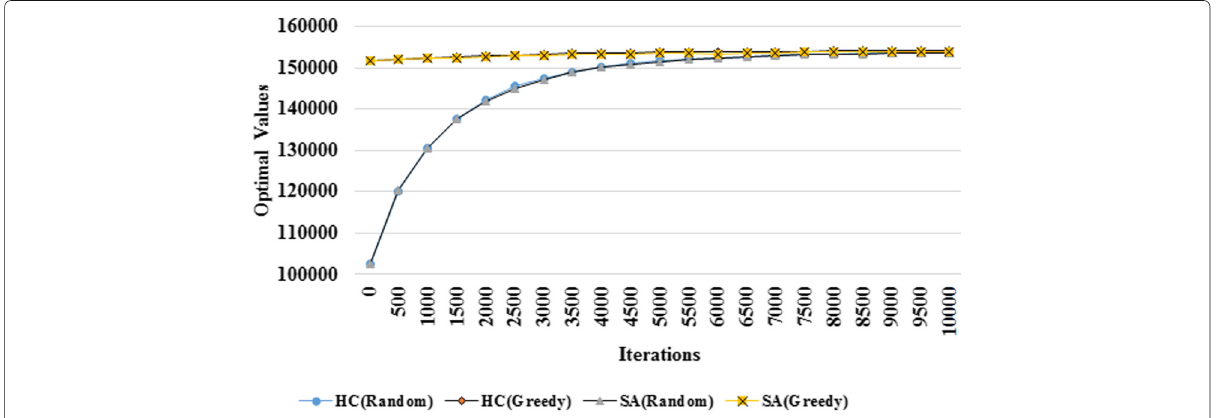
Fig. 10 Run Length Distribution for a Large Instance(C(500,20,4))